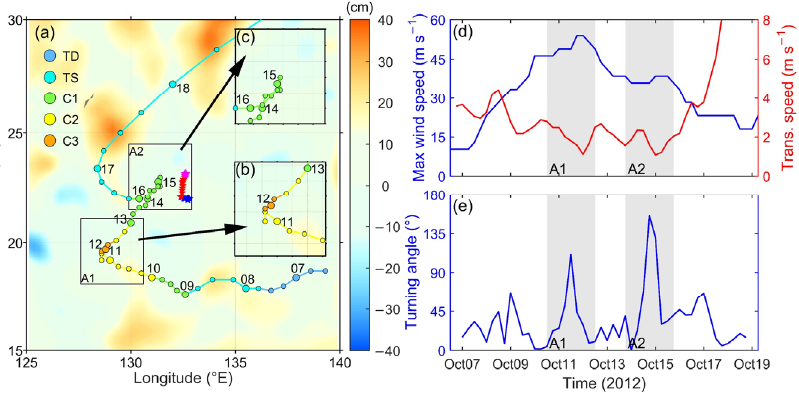
Figure 1. ( a ) Best track of Typhoon Prapiroon in October 2012 and spatial distribution of the pre- typhoon sea surface height anomaly (SSHA). The blue, red, and pink stars represent the positions of the Argo observations before, during, and after Prapiroon’s passage. The two black boxes indicate 2 ◦ × 2 ◦ domains related to the two sudden-turning stages, denoted A1 and A2. The coloured lines and dots represent the track and intensity of the typhoon: steel blue, cyan, green, yellow, and orange dots represent the intensity at Tropical Depression (TD), Tropical Storm (TS), and Category 1–3, respectively. ( b , c ) Magnification of A1 and A2 in ( a ). ( d ) Temporal evolution of the maximum wind speed (blue solid line) and translation speed (red solid line) of Prapiroon. ( e ) Temporal evolution of the turning angle of Prapiroon. The grey shaded areas in ( d , e ) indicate the two sudden-turning stages (A1-ST and